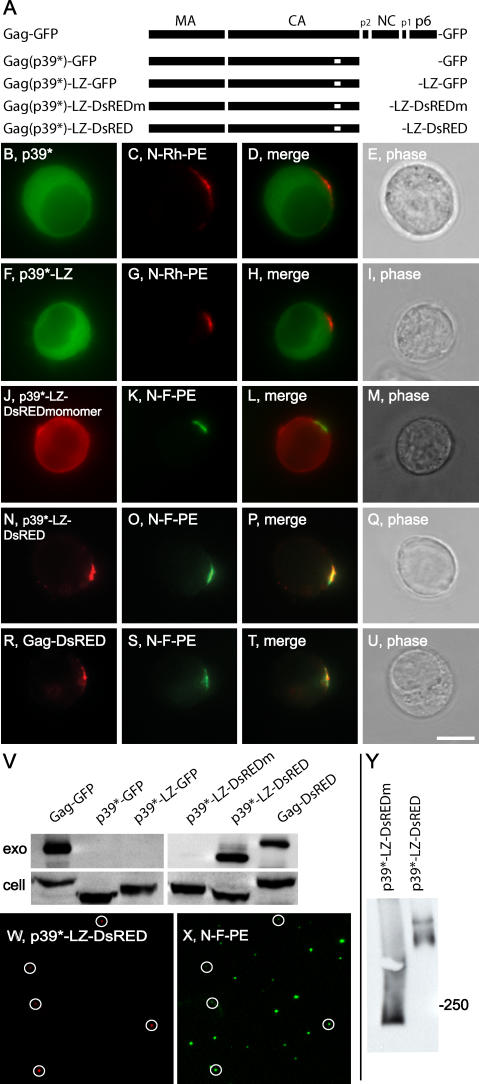
Higher-Order Oligomerization Targets HIV Gag to ELDs and Exosomes(A) Line diagram of full-length HIV Gag and mutant Gag-GFP proteins.(B–I) Fluorescence micrographs of N-Rh-PE–labeled Jurkat T cells expressing (B–E) HIV Gag(p39*)-GFP or (F–I) HIV Gag(p39*)-LZ-GFP.(J–U) Fluorescence micrographs of N-F-PE–labeled Jurkat T cells expressing (J–M) HIV Gag(p39*)-LZ-DsREDmonomer, (N–Q) HIV Gag(p39*)-LZ-DsRED, or (R–U) HIV Gag-DsRED.(V) Anti-Gag immunoblot of exosome (exo) and cell lysates (cell) of Jurkat T cells expressing (lane 1) full-length HIV Gag-GFP, (lane 2) HIV Gag(p39*)-GFP, (lane 3) HIV Gag(p39*)-LZ-GFP, (lane 4) HIV Gag(p39*)-LZ-DsREDmonomer, (lane 5) HIV Gag(p39*)-LZ-DsRED, or (lane 6) HIV Gag-DsRED, all loaded at the same ratio of exosome:cell lysate.(W and X) Fluorescence micrographs of exosomes secreted by N-F-PE–labeled Jurkat T cells expressing HIV Gag(p39*)-LZ-DsRED. White circles mark exosomes that contain both N-F-PE and Gag(p39*)-LZ-DsRED.(Y) Anti-Gag immunoblot of native cell lysates generated from Jurkat T cells expressing (left lane) HIV Gag(p39*)-LZ-DsREDmonomer or (right lane) HIV Gag(p39*)-LZ-DsRED, separated by native gel electrophoresis. Bar indicates 10 μm.